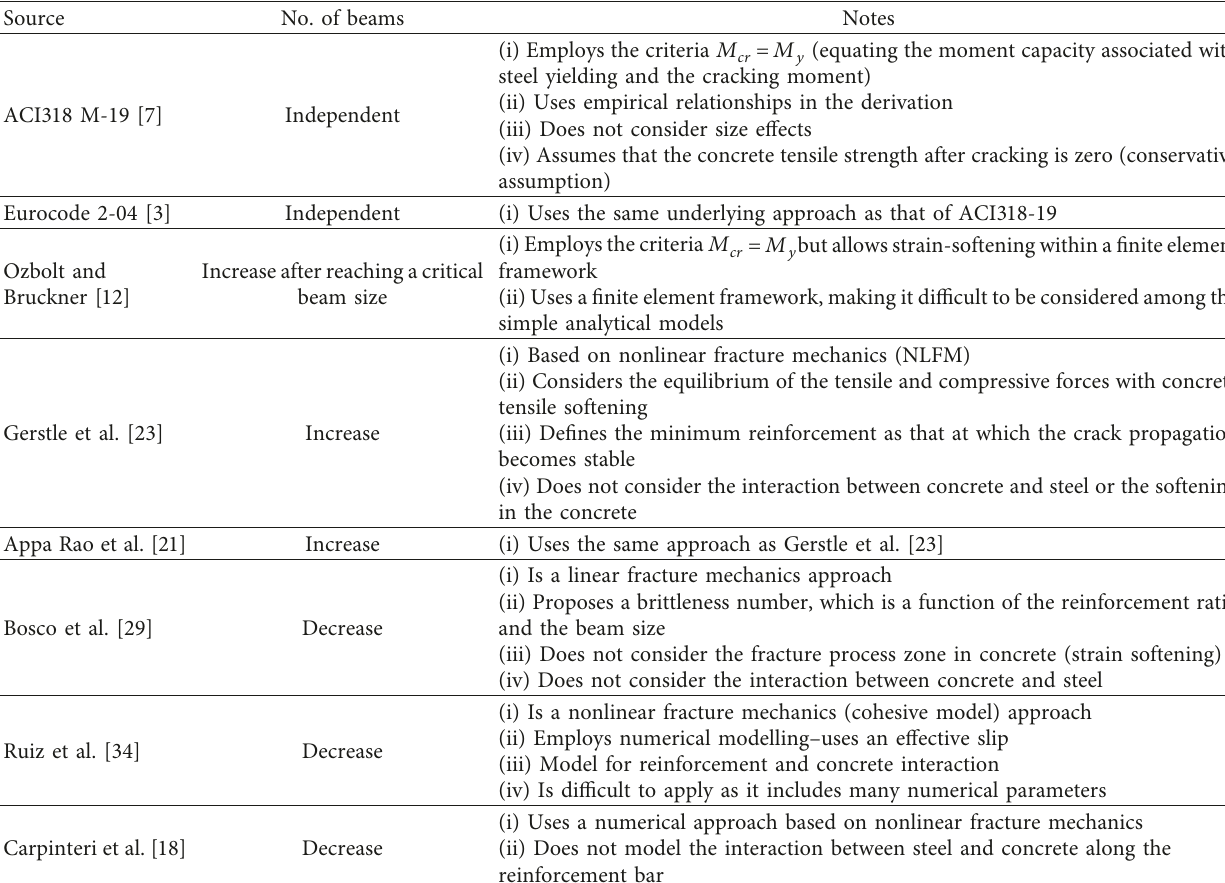
Table 4: Effect of member depth on the minimum reinforcement ratio according to various